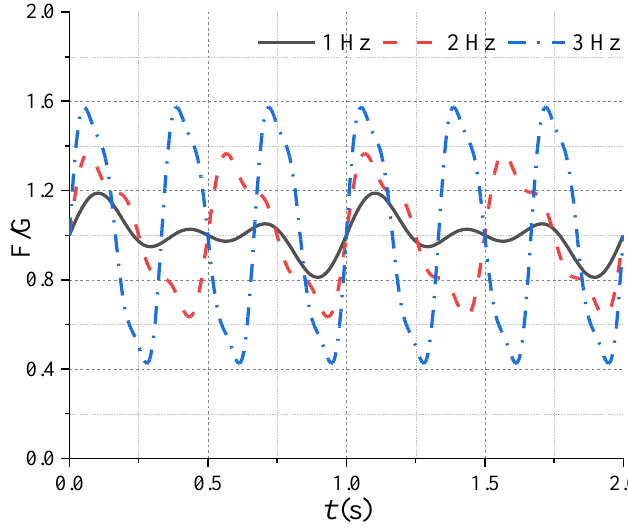
Figure 11. Time history curve of single person walking load. The root-mean-square (RMS) of acceleration is a function of time. Considering the influence of the overall acceleration response in the time history, it can better reflect the attribute of structural response than the peak acceleration [49,50]. This paper divided the acceleration time history data into calculation windows by 0.5 s, and the RMS of acceleration in each window was calculated by MATLAB (Equation (2)). For condition one, the acceleration time history and the RMS curve of measuring point H-3 are shown in Figure 12. a w = where a w ( t ) is the acceleration time history (m/s 2 ), T is the total time (s), and a w is the RMS of acceleration within the calculation window.